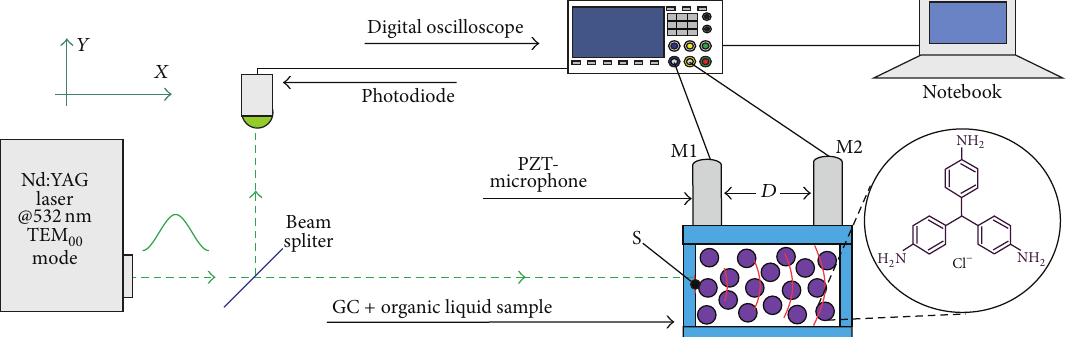
Figure 1: Schematic representation of the experimental device implemented to estimate the acoustic attenuation coefficient and the speed of sound in CV/H 2 O based dissolutions via the PLPA-technique (molecular structure of the CV-compound).